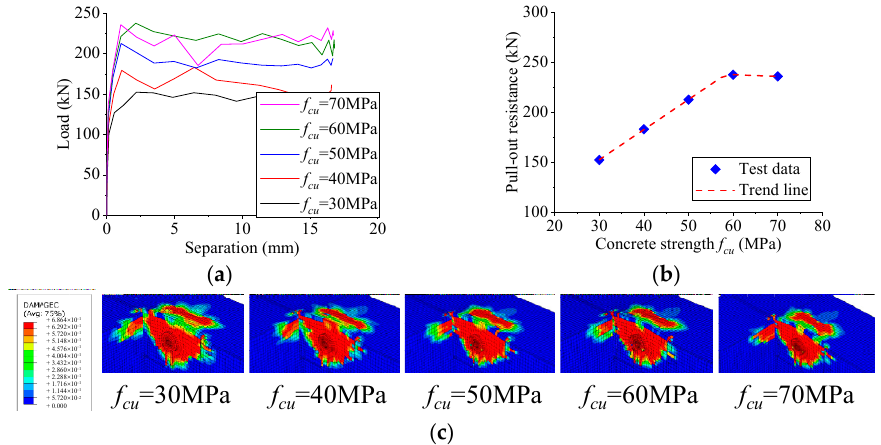
Figure 17. Influence of concrete strength. ( a ) Load–separation curves; ( b ) influence analysis; ( c ) failure mode.